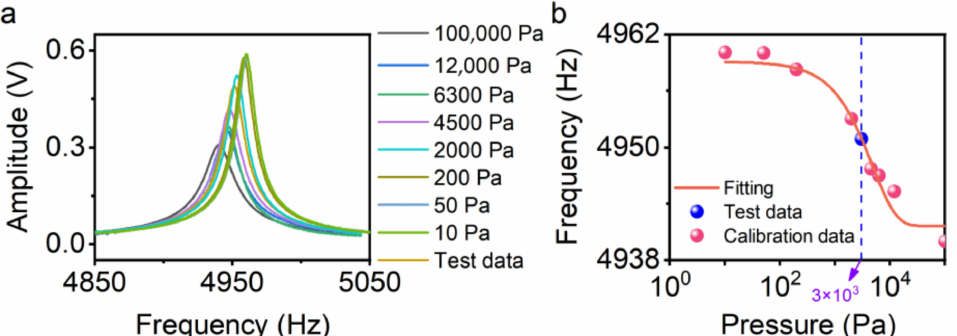
Figure 10. Variation of resonant frequency of cantilever with air pressure of the microparticle chamber prepared for optical levitation test. ( a ) Resonance spectrum; ( b ) Calibrating